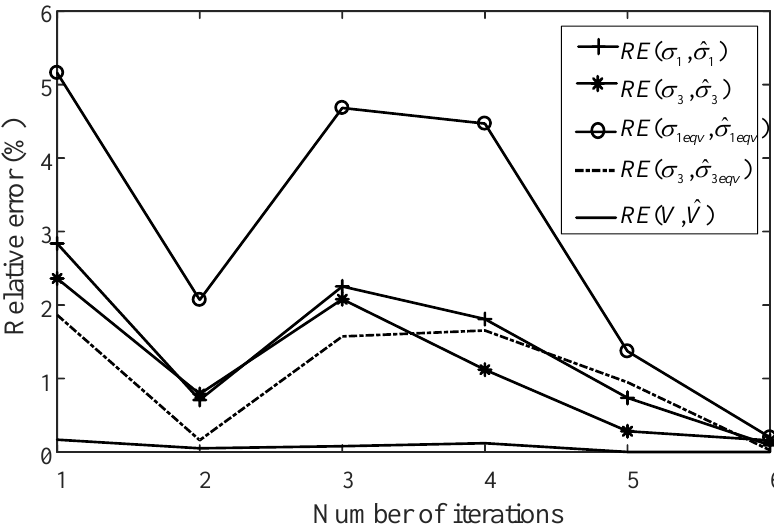
Figure 5. The variation of relative errors between σ 1 and ˆ σ 1 , σ 3 and ˆ σ 3 , σ 1 eqv and ˆ σ 1 eqv , σ 3 eqv and ˆ σ 3 eqv , and V and ˆ V involved in GA-SKSM with number of iterations increasing.